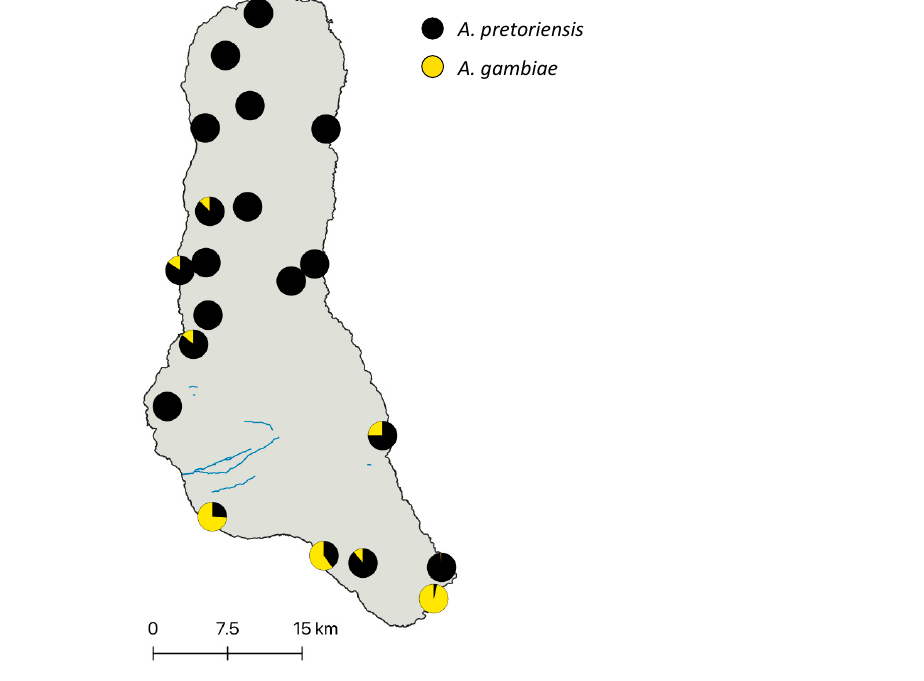
Figure 1. Relative abundance of Anopheles spp. in Grande Comore Island. Map of sampling sites where immature specimens of Anopheles were collected across Grande Comore. Pie charts display relative abundance of A. gambiae (yellow) and A. pretoriensis (black).